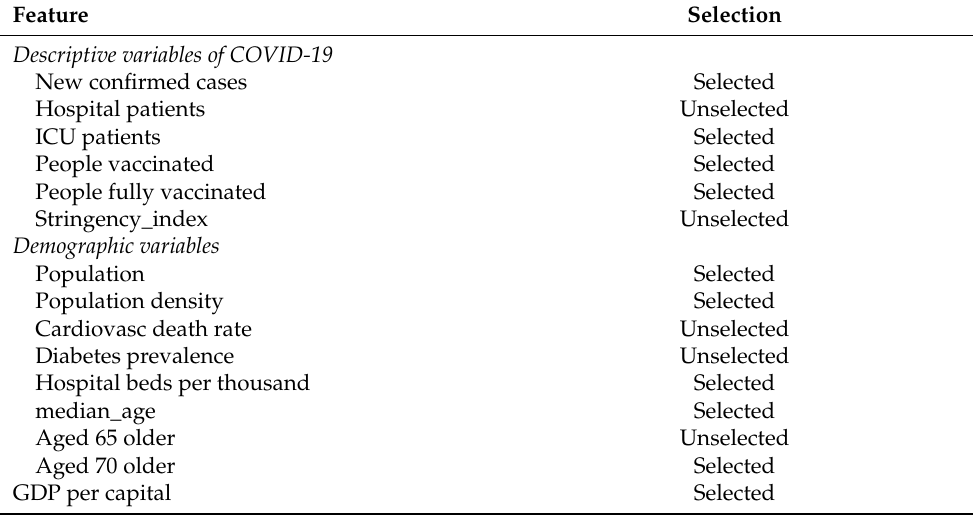
It can be discovered that the prediction of the proposed system was close to the real the outbreak. For example, there was an obvious increase in the number of death cases in Japan during the prediction period (i.e., 18 January 2022–22 February 2022). In the actual data, the number of daily death cases grew rapidly from 10 to 332 within four weeks. This abnormal surge was captured by the system effectively. In addition, the following trend in the epidemic situation was also predicted by the system. The results indicate that the performance of the proposed system is